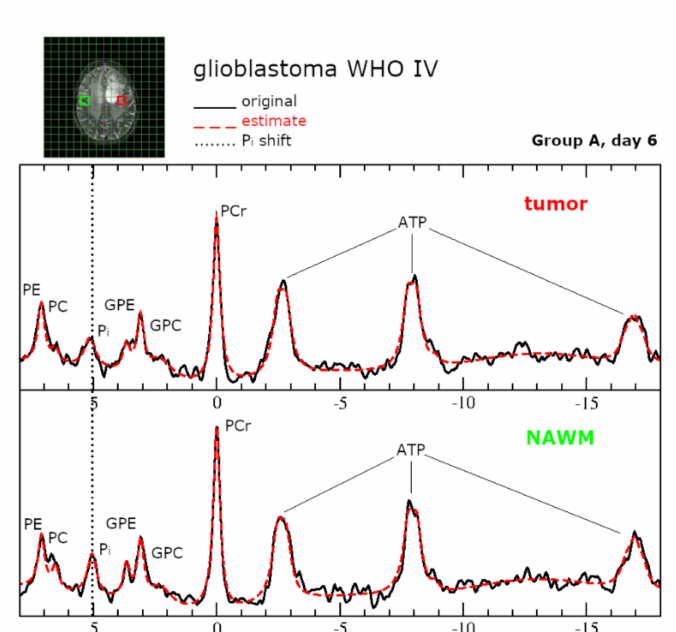
Figure 5. Representative 31 P spectra for tumor tissue and NAWM at 3T. Green (NAWM) and red (tumor) boxes indicate voxel positioning on T2WI. The original spectrum is depicted as a black line and the spectral fit as a red dotted line. One signal was used to model the inorganic phosphate (P i ). At physiological pH, H 2 PO 4 , and HPO 4 ions contribute to the P i signal. Since both components have di ff erent chemical shift, the chemical shift (signal position) of inorganic phosphate (P i ) is pH dependent and can be used as a